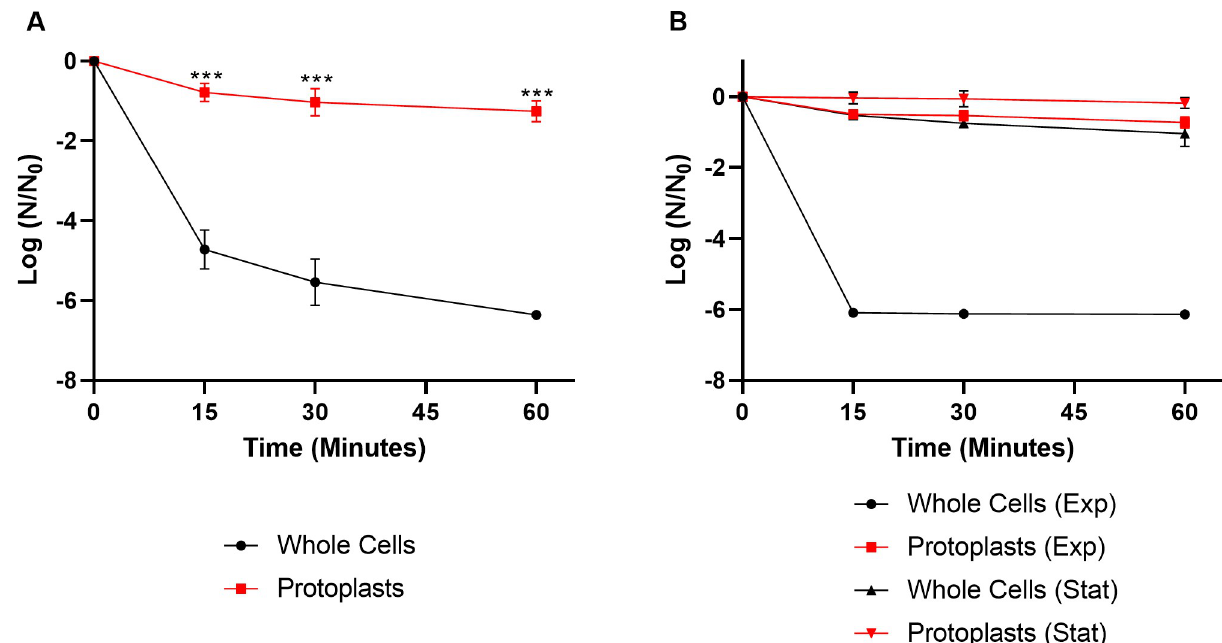
Fig 5. Removal of peptidoglycan increases tolerance to daptomycin in E . faecalis . (A) Cells were grown to mid-logarithmic phase, split, and treated with either lysozyme to generate protoplasts or solvent control (whole cells) and then treated with 30 μ g/mL daptomycin. Shown are the average log ratios of colony forming units ± standard deviations for n = 3 replicates. ��� P � 0.001; exact P -values are found in S4 Table. (B) Cells were grown to mid-logarithmic phase (Exp) or to late stationary phase (24 hour cultures; Stat) and treated with either lysozyme to generate protoplasts or solvent control (whole cells) and then treated with 30 μ g/mL daptomycin. Shown are the average log ratios of colony forming units ± standard deviations for n = 3 replicates.